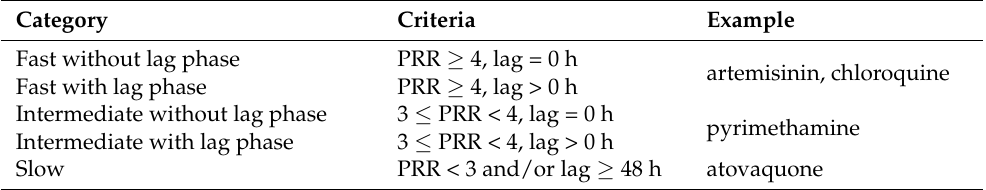
Table 1. Definition of categories used for pharmacodynamic ranking for